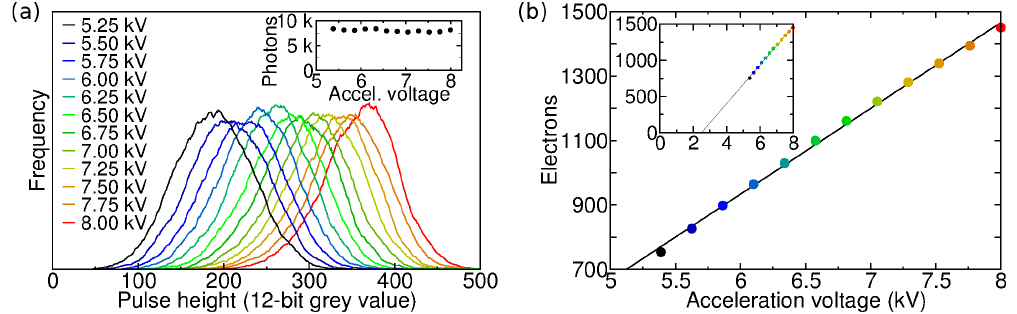
Figure 4. ( a ) Photon event pulse height distributions for different acceleration voltage settings, measured with a Hamamatsu EBCCD. The count rate and number of acquired frames was the same for each setting, resulting in the integral of the distributions being similar (inset); ( b ) Mean pulse height in electrons versus acceleration voltage. A straight line fit yields a gradient of 266 e/kV, from which an electron-hole pair generation energy in silicon, 3.76 eV, can be obtained. The inset shows the same data with extended data range; the threshold voltage 2.5 kV is at y =